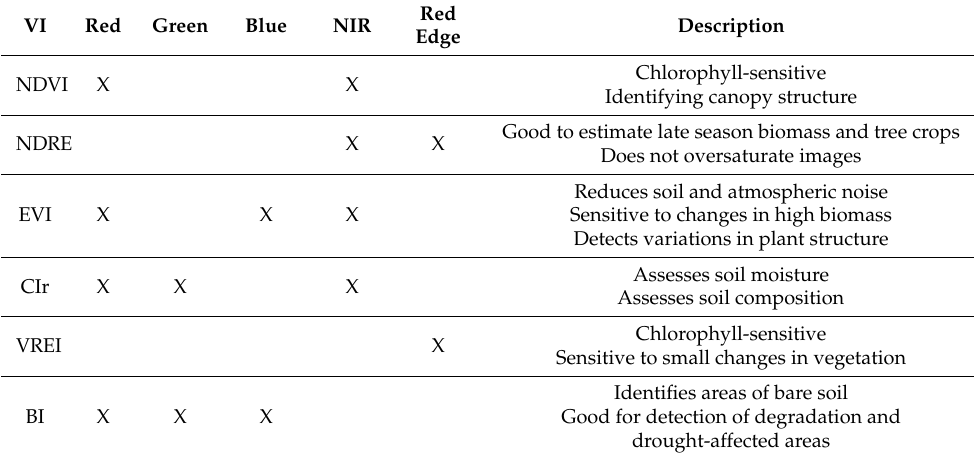
Table 2. Vegetation indices included in the study, and associated bands used to calculate the vegeta- tion indices, and